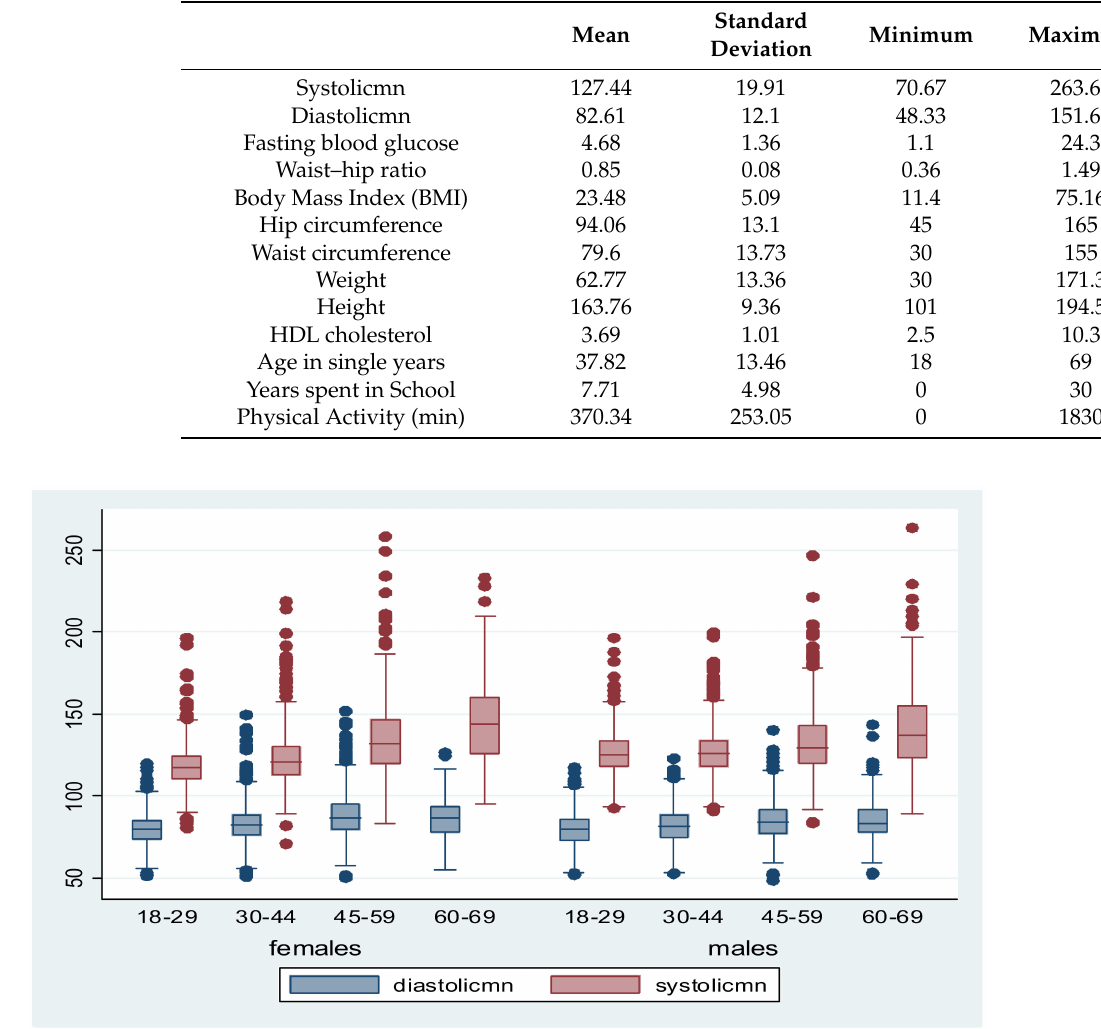
Figure 1. Systolic and diastolic distribution in both and by genders box